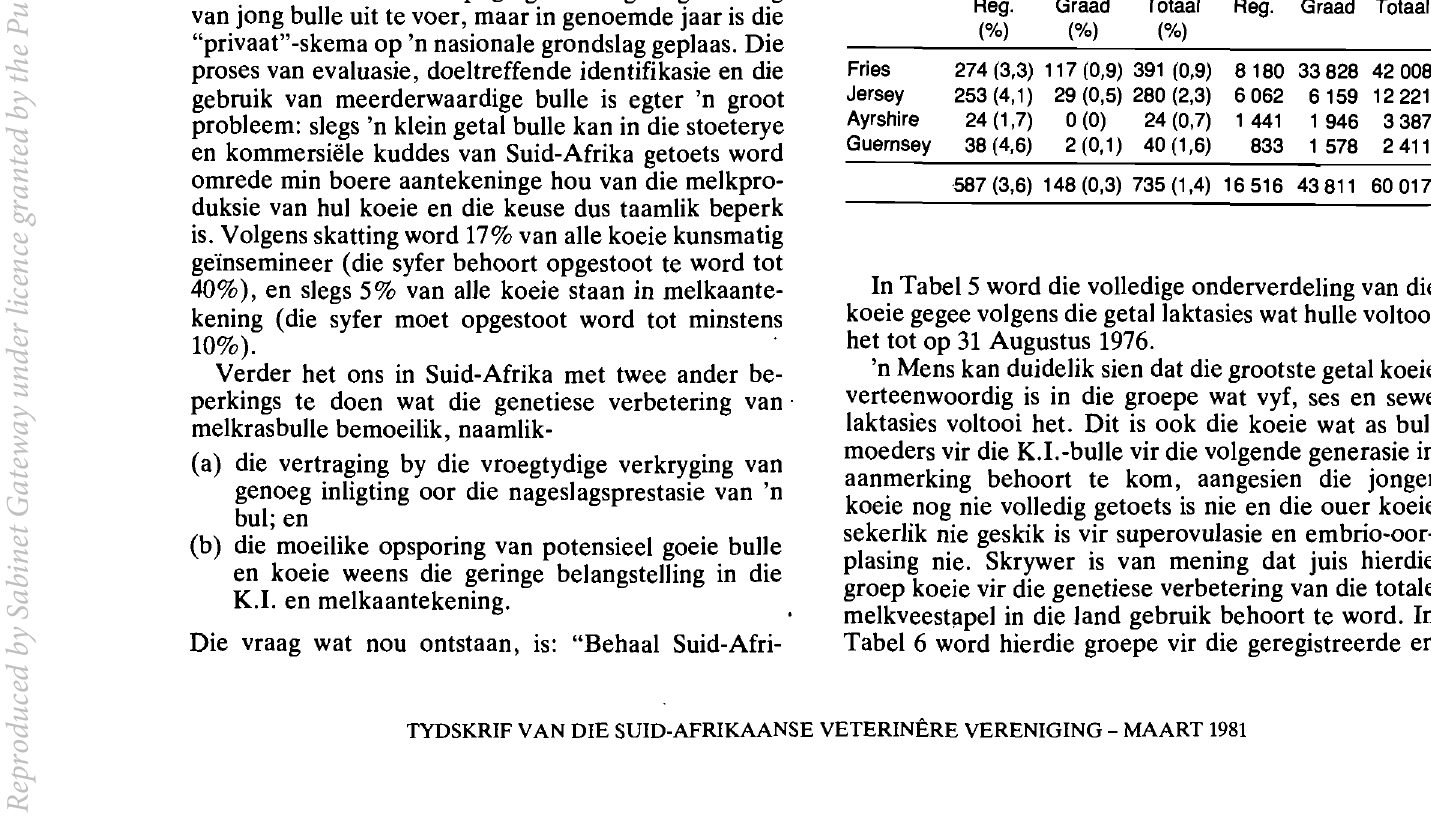
Tabel 4: MELKRASKOEIE WAT OP LEEFTYOS